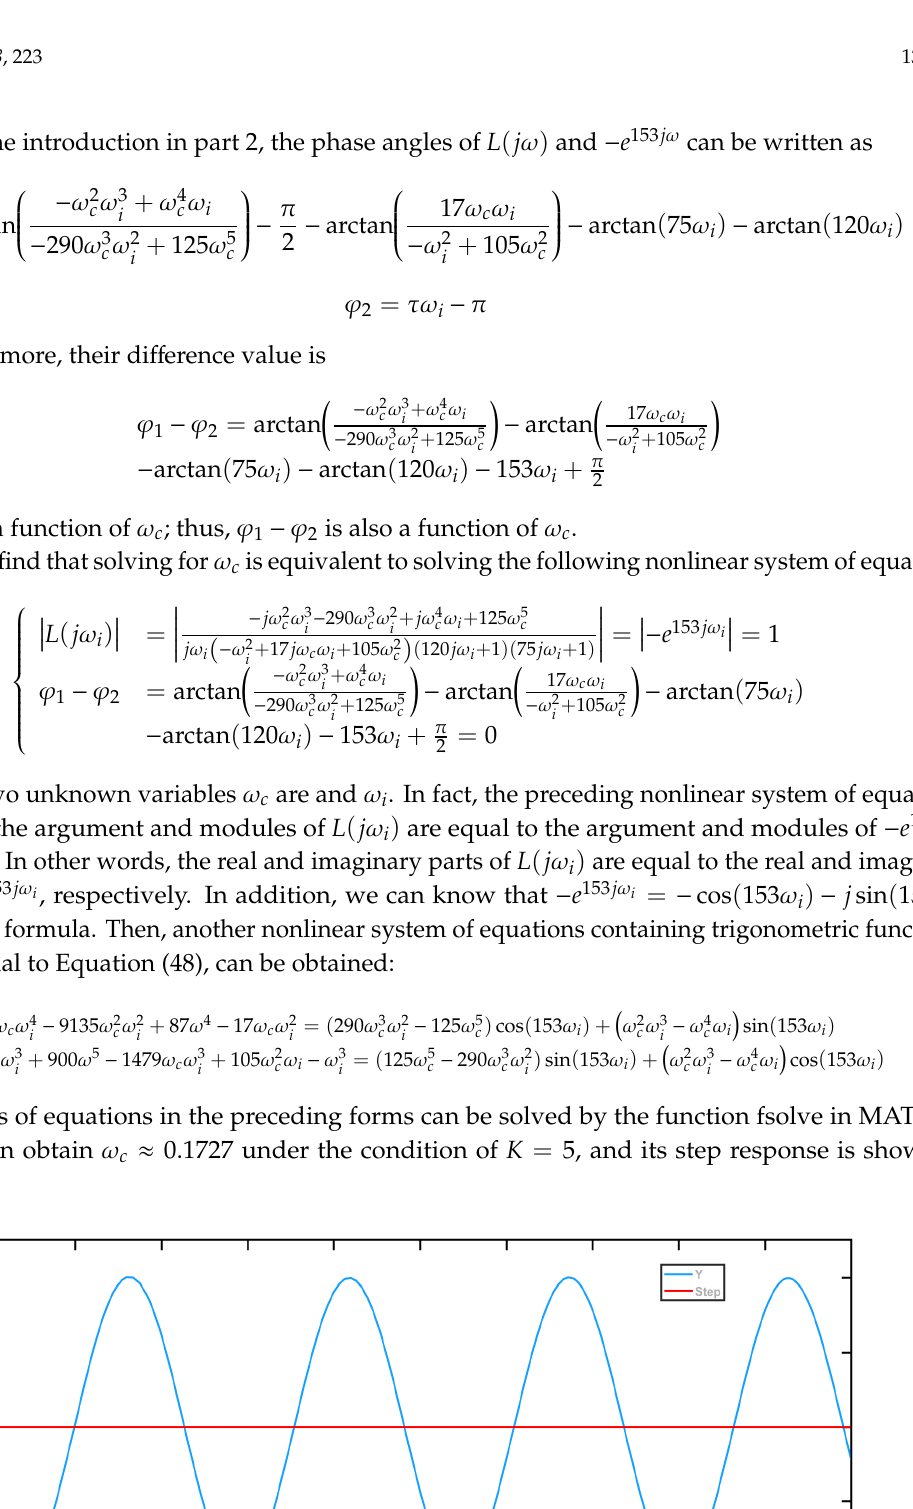
Figure 8. Step Response of Second-Order Time-Delay System When ω c ≈ 0.1727 and K = 5 .